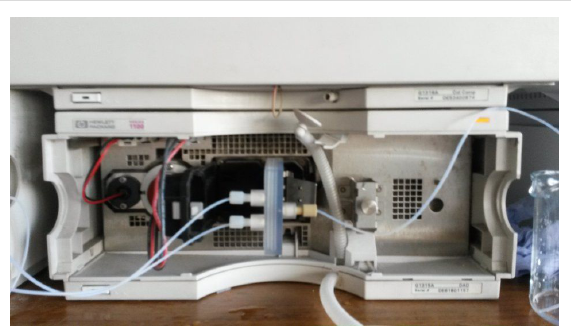
Figure 4: RD1 held in place within the DAD compartment of an Agilent 1100 HPLC.